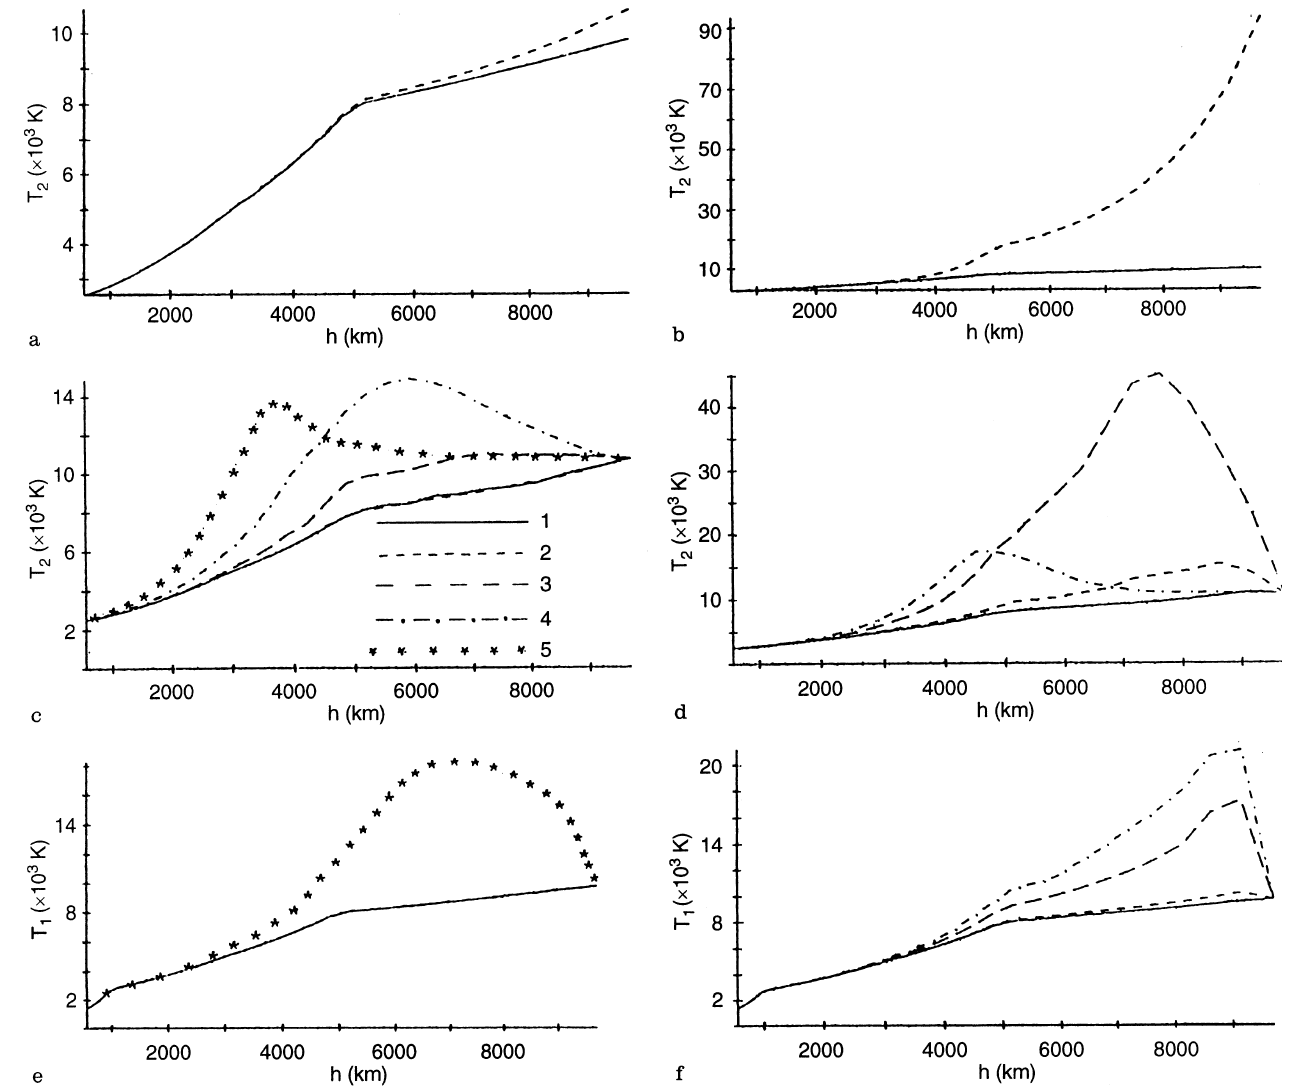
(cid:136) 1 (cid:1) 10 (cid:255) 6 (cid:133) 1 (cid:1) 10 (cid:255) 5 (cid:134) A/m 2 . Under such conditions, j 2 the e(cid:128)ects of turbulence are negligible and Eqs. (18) < h < h excluding the lower and (19) are valid for h b m k T (cid:134) (cid:20) 1 (cid:1) 10 (cid:255) 3 . To altitudes of this region when W = (cid:133) n 2 B 2 stress on the e(cid:128)ects of turbulence, we give the maximum k T (cid:134) as equal to 1 (cid:1) 10 (cid:255) 2 at h (cid:136) h . The value of W = (cid:133) n 2 B 2 m calculated temperature of protons corresponds approx- imately to that presented in Fig. 1. In contrast in Fig. 2a,b, the di(cid:128)erence between the electron temperatures T 2 (the dashed curves) and T (cid:3) (the solid curves) increases 2